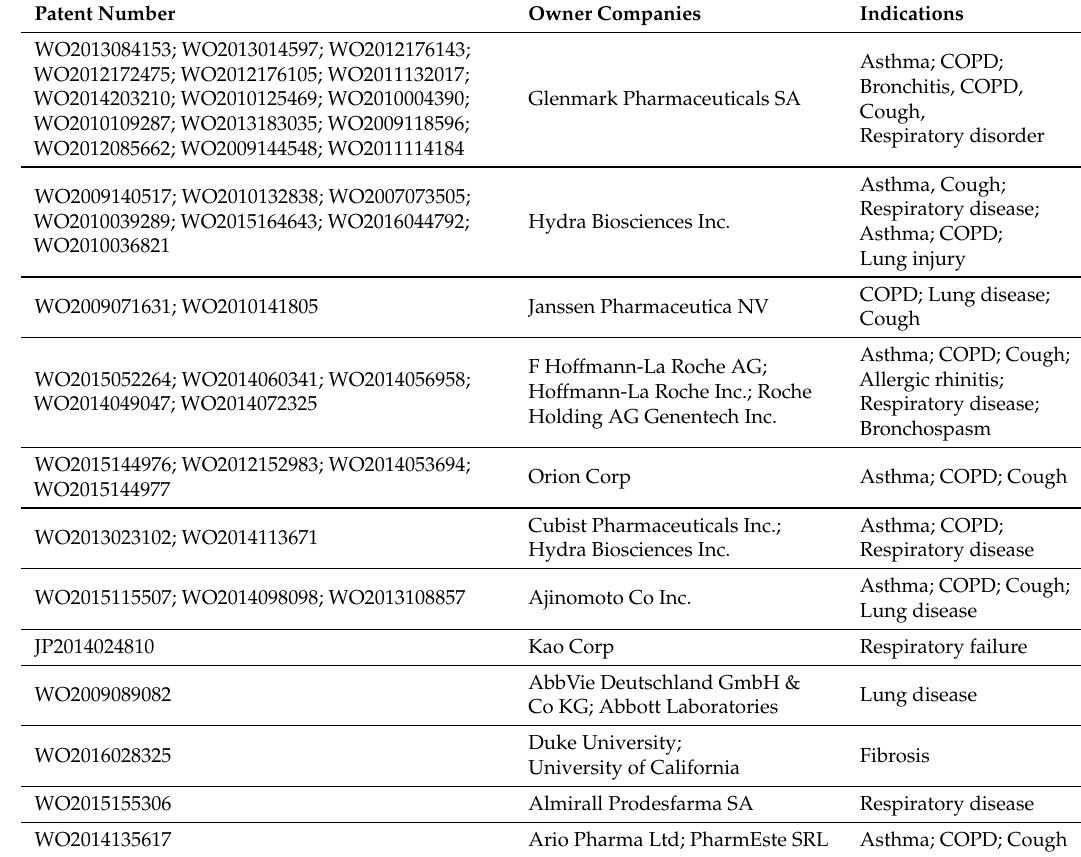
Table 1. TRPA1 in Respiratory Diseases: A Patent